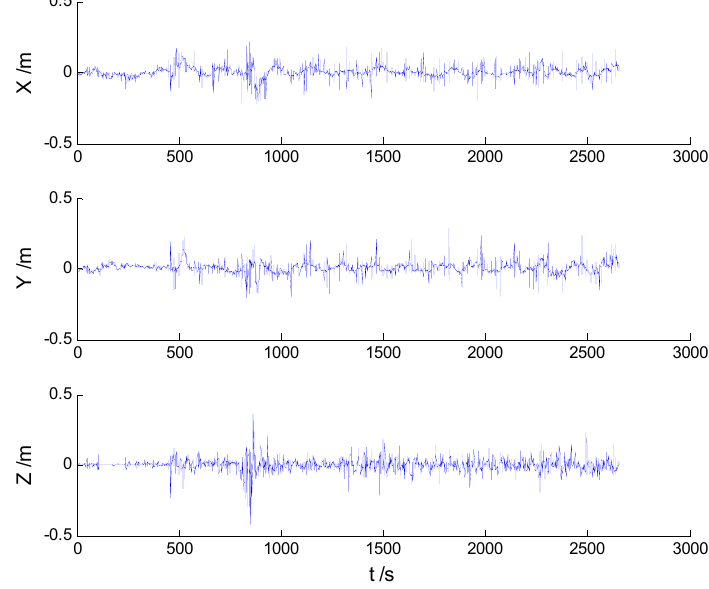
Figure 3. Position errors of the adaptive Kalman filter (AKF) algorithm. Sensors 2016 , 16 , 2127